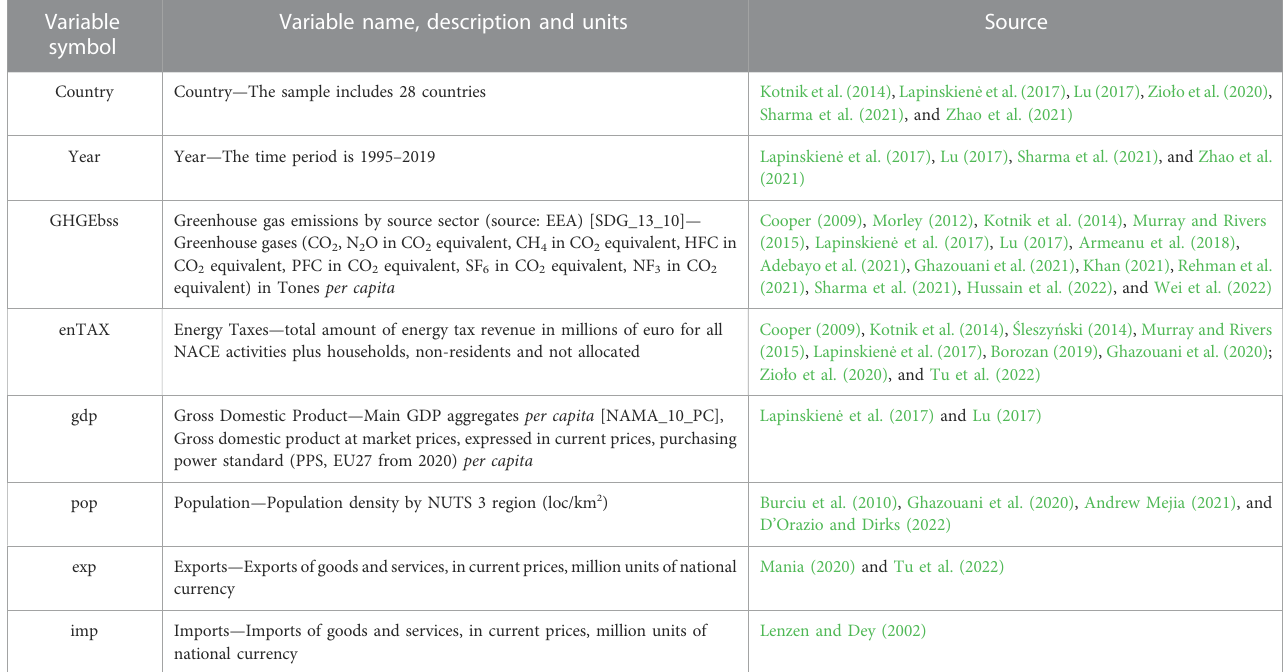
TABLE 1 Variables de fi nition, sources and economic literature usage. Variable